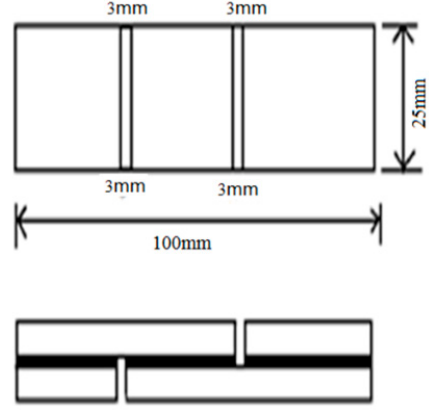
Figure 2. Sample schematic for lap-shear testing (100 mm × 25 mm × 4.0 mm), with two layers of pine veneers coated with one layer of adhesive .